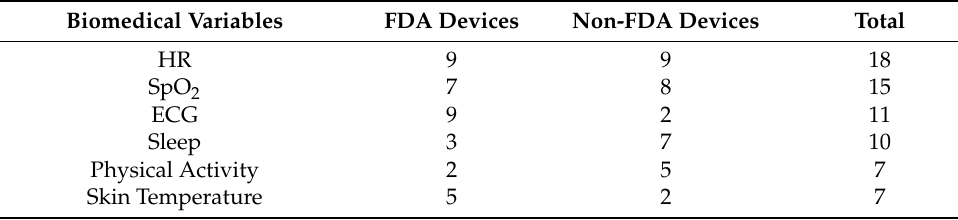
Table 2. CVD biomedical variables monitored by commercial wearable technology.